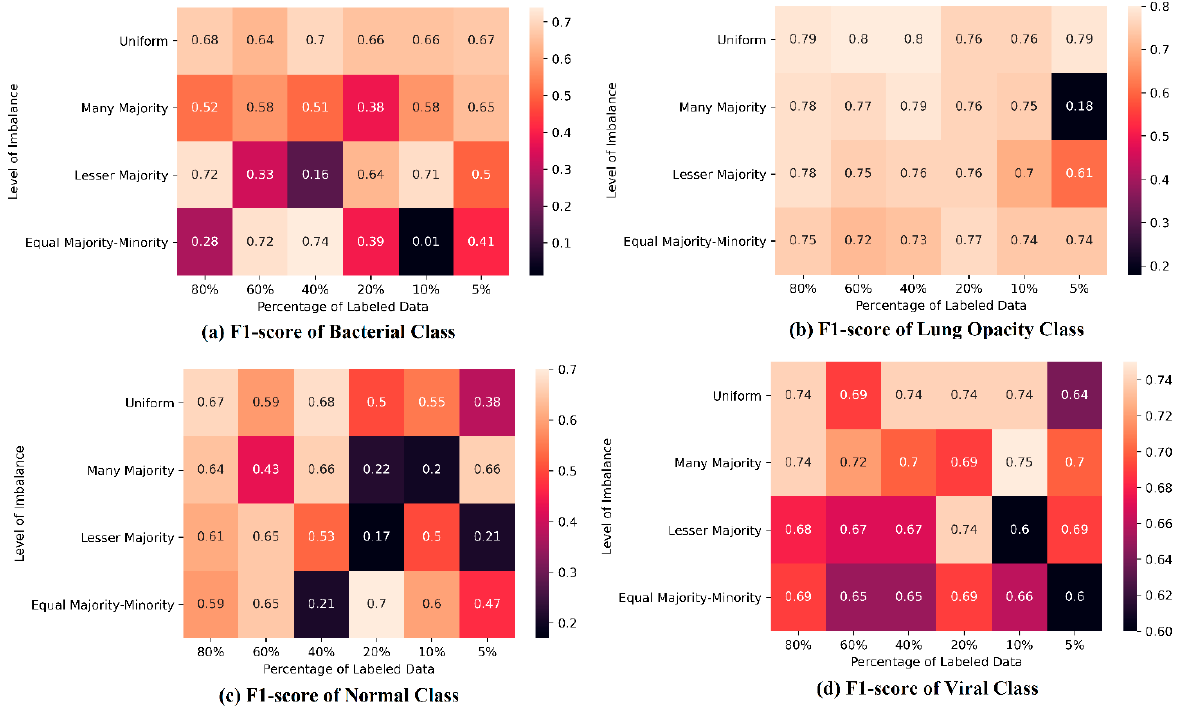
Figure 6. Class wise F1-score for varied labeled samples and 4 levels of imbalance.